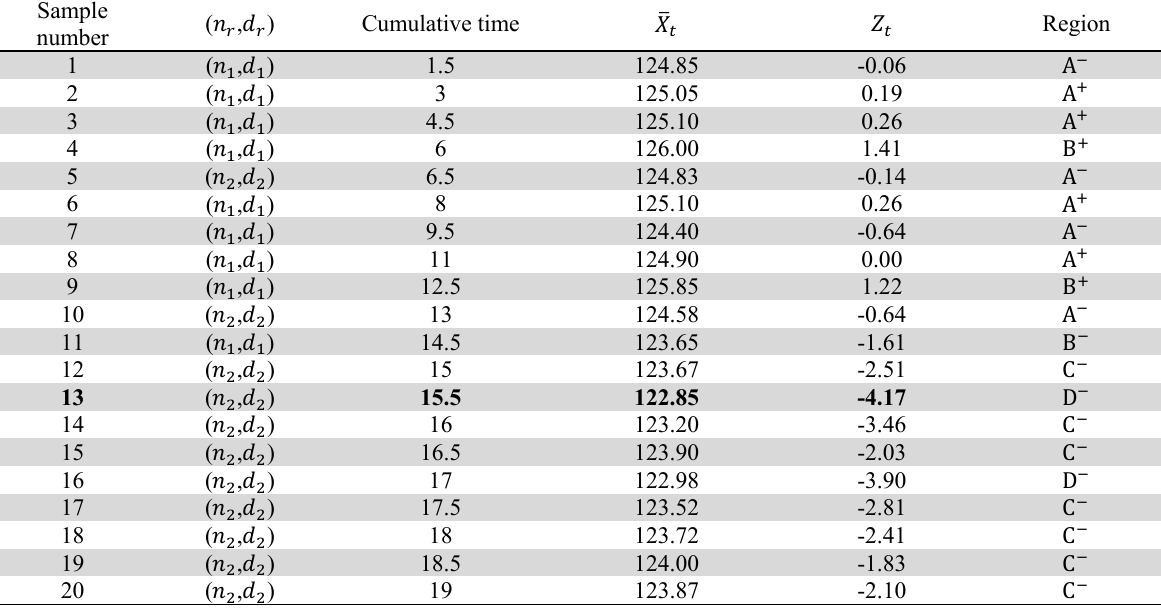
The charting statistics of the VSSI-Synth / VSSI-Runs monitoring scheme using the 1&2 sampling strategy